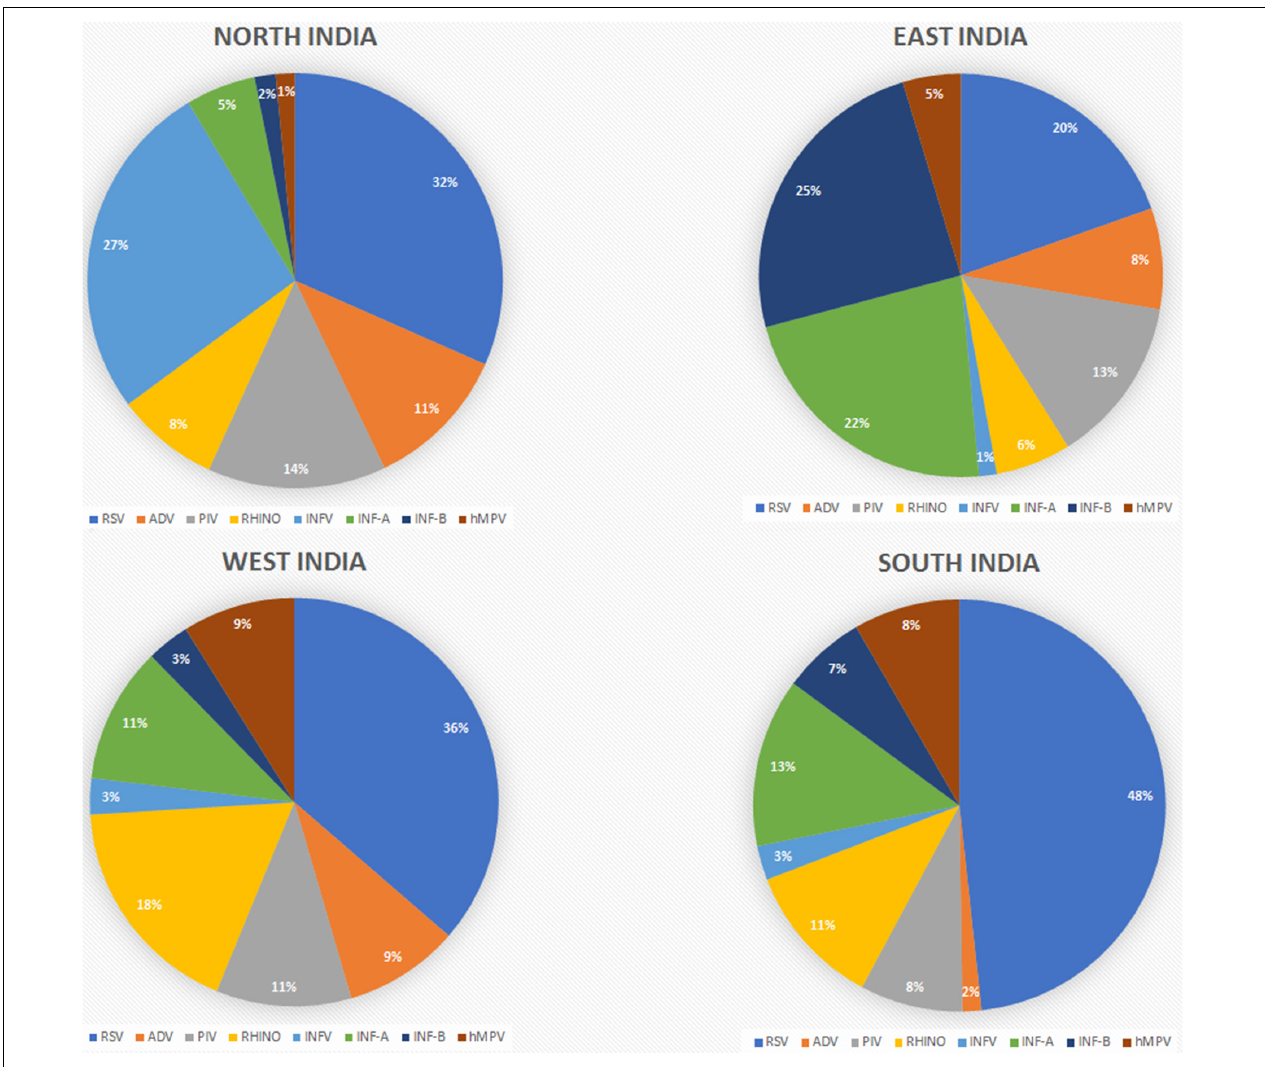
FIGURE 2 | Prevalence of viral infections based on the geographical regions in India.